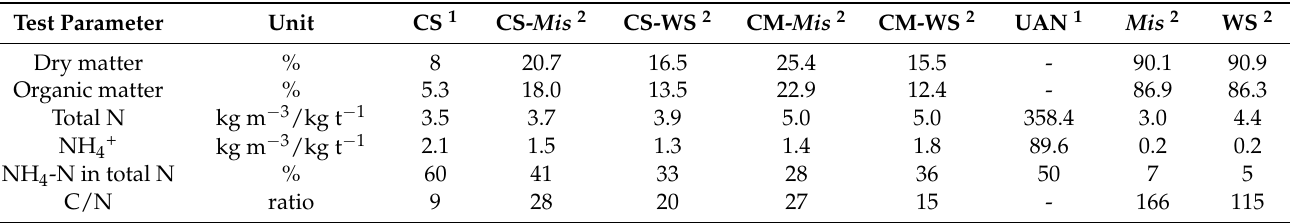
Table 4. Nutrient contents of the used treatments for experiment 3 (170 kg total N ha − 1 ), (CS = Cattle Slurry, CS- Mis = Cattle Slurry- Miscanthus (5 kg to 1 kg), CS-WS = Cattle Slurry-Wheat Straw (8.5 kg to 1 kg), CM- Mis = Cattle Manure from Miscanthus shredded bedding, CM-WS = Cattle Manure from Wheat Straw shredded bedding, UAN = Urea Ammonium Nitrate, Mis = Miscanthus -shredding, WS = Wheat Straw-shredding).